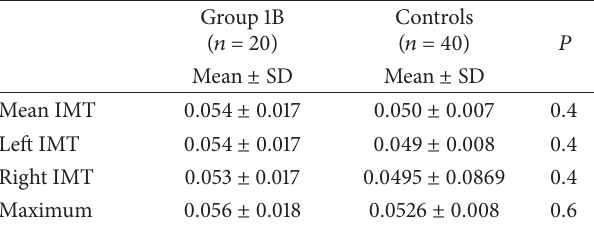
Table 9: Comparison of endothelial function between group 1A patients and controls.